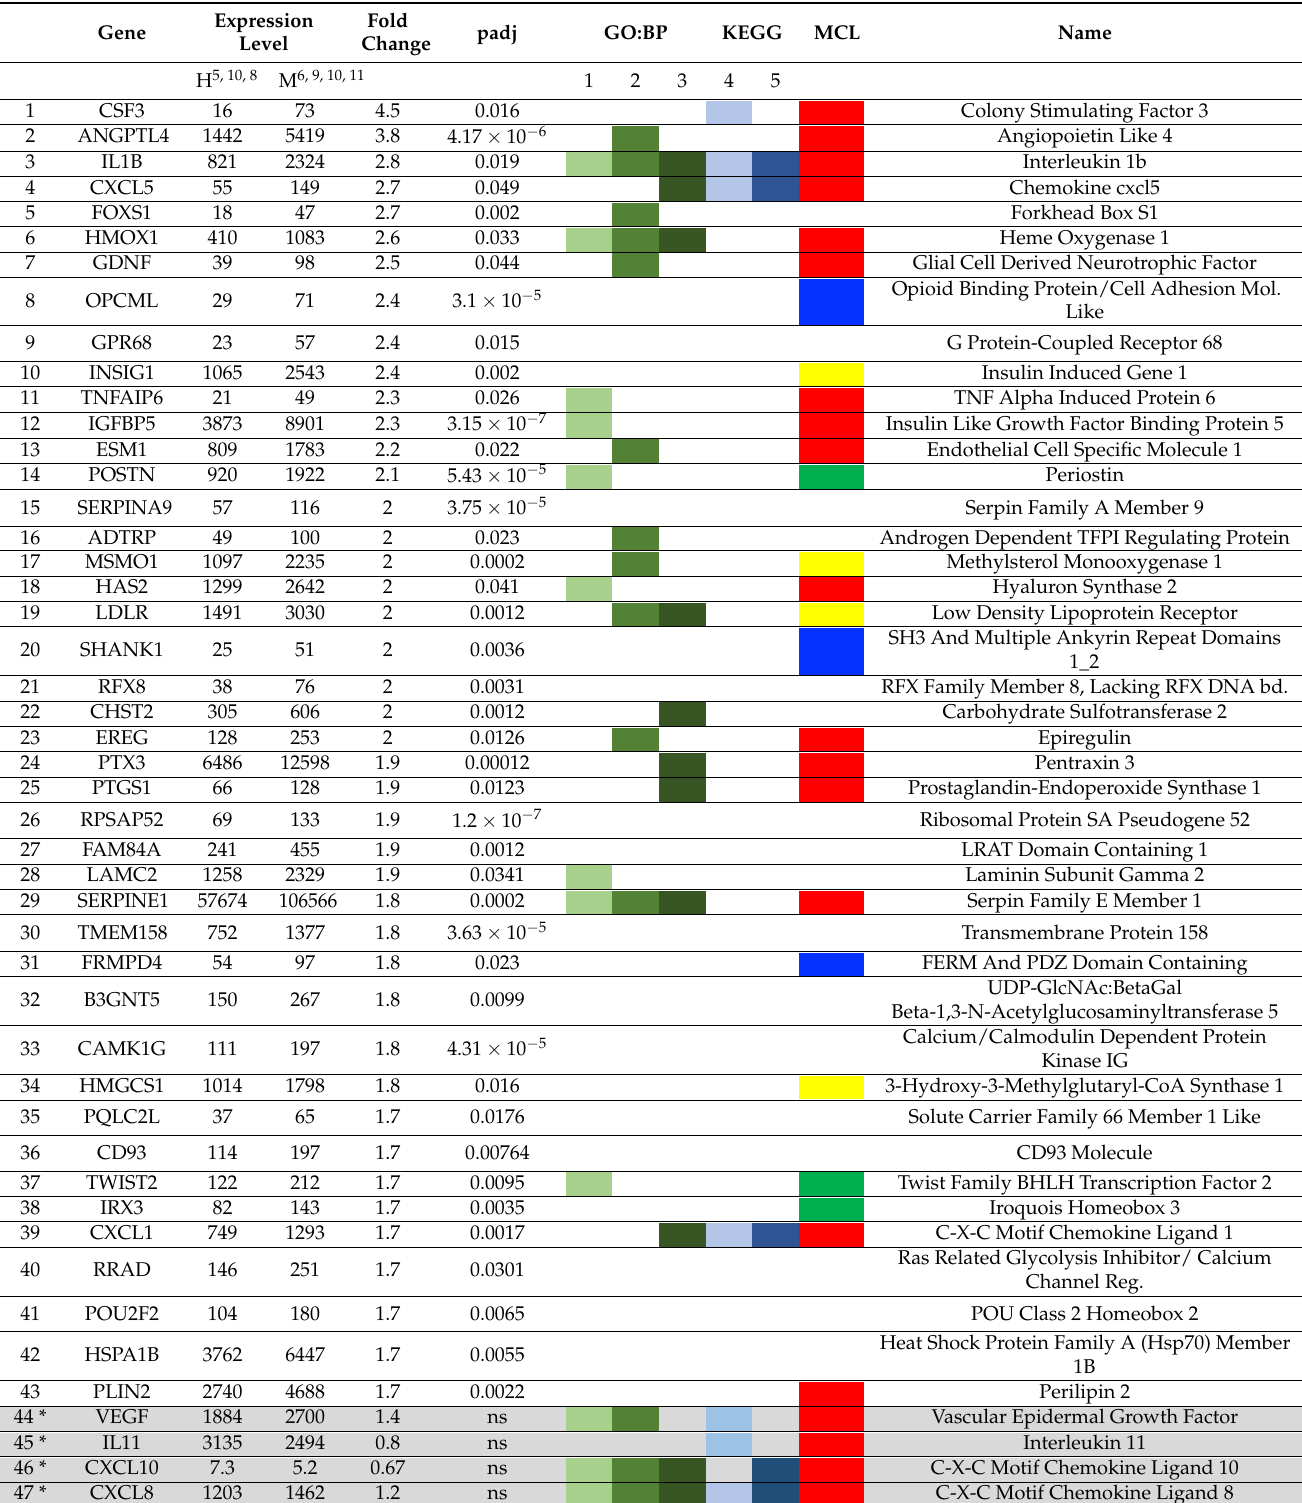
Table 1. Genes differentially higher expressed ( ≥ 1.7 fold) in endothelial cells incubated with plasma from malaria patients (M6, M9, M10, and M11) compared to incubation with plasma from healthy controls (H5, H10, and